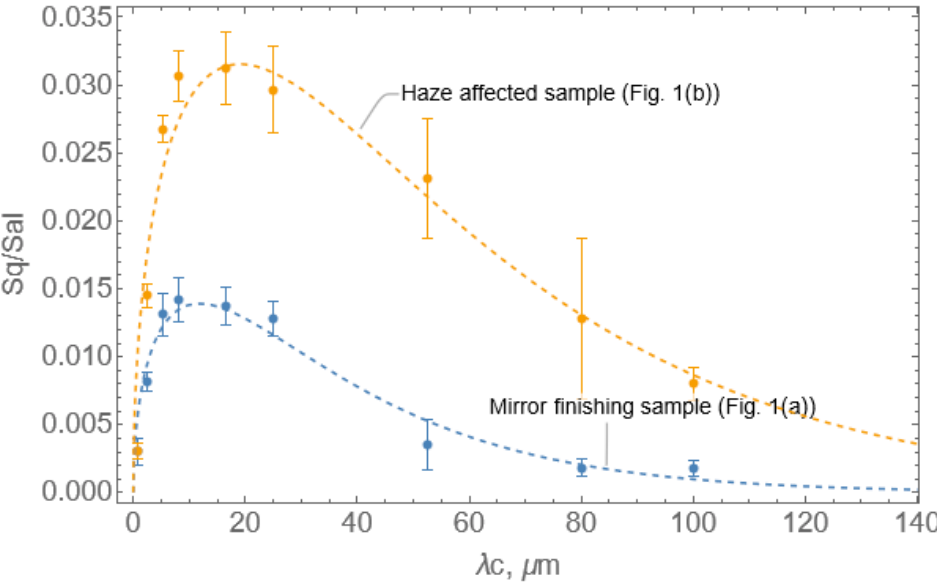
Figure 5. Fits of the data of slope parameter S q / S al vs. λ c , to the function of Equation (3), for the two representative samples shown in Figure 1. Table 2. Values of the fitting parameters A and B from Equation (3), along with the values of the correlation coefficient r of these fits, as well as the values of the roughness slope parameter S q calculated according to Equation (4), for the set of AISI 430 ferritic stainless steel samples under study. Samples #18 corresponds to the mirror-finished sample shown in Figure 1a. Sample #25 corresponds to the haze-affected sample shown in Figure